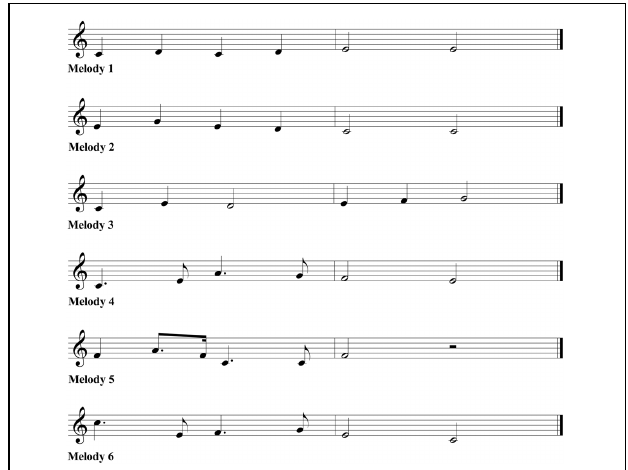
FIGURE 1 | Score of novel melodies used in Task 3 of the